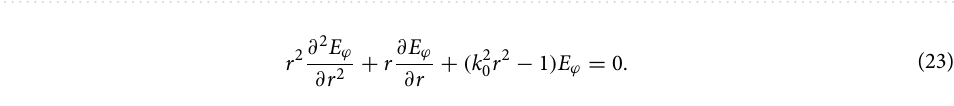
Figure 6. The amplitude of the alternating electromagnetic field in the solenoid varying with the frequency. ( a ) Magnetic field; ( b ) electric